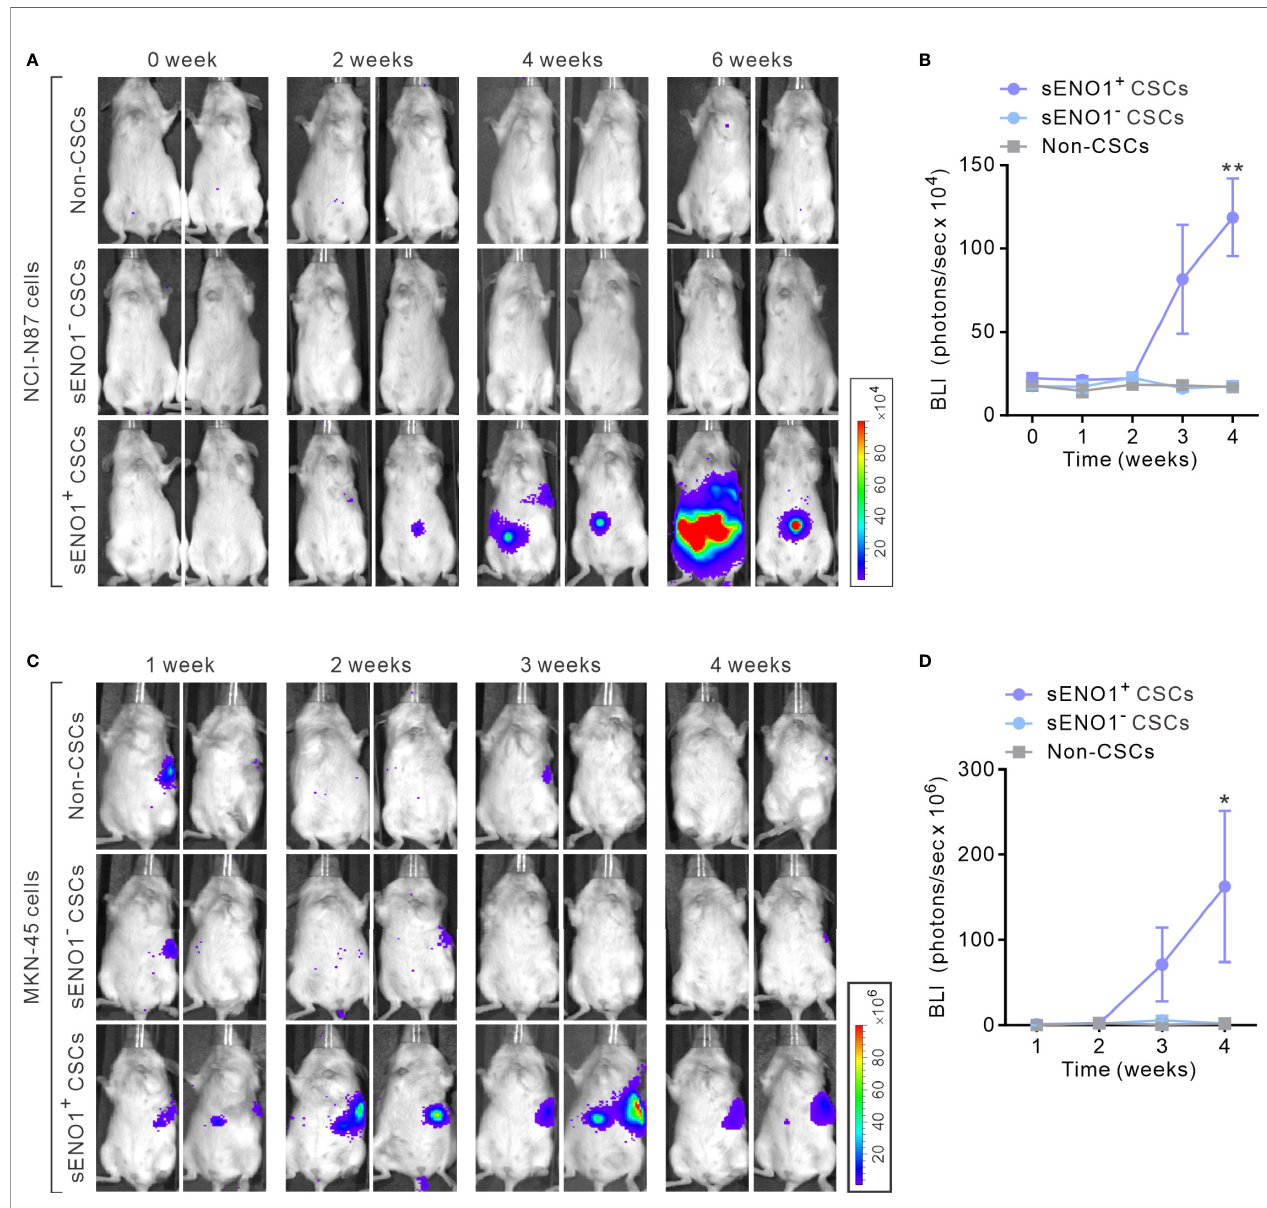
FIGURE 3 | sENO1 + CSCs are highly pro-metastatic. (A) Representative BLI of NOD/SCID mice receiving an intra-splenic injection of sENO1 + CSCs (represented by CD90 + NCI-N87 cells), sENO1 - CSCs (CD90 - NCI-N87 cells), and non-CSCs (represented by CD90 - cells). at the indicated time following cell inoculation. (B) Tumor bulk quanti fi ed as BLI normalized photon counts as a function of time. Error bars represent mean ± SEM from one experiment (n = 8 mice per group). Unpaired t-test was performed throughout where **p < 0.01 versus non-CSCs. (C) Representative BLI of NOD/SCID mice receiving intra-splenic injection of sENO1 + CSCs (represented by CD90 + MKN-45 cells), sENO1 - CSCs (CD90 - MKN-45 cells) and non-CSCs (represented by CD90 - cells). at the indicated time following cell inoculation. (D) Tumor bulk quanti fi ed as BLI normalized photon counts as a function of time. Error bars represent mean ± SEM from one experiment (n = 8 mice per group). Unpaired t-test was performed throughout where *p < 0.05 versus